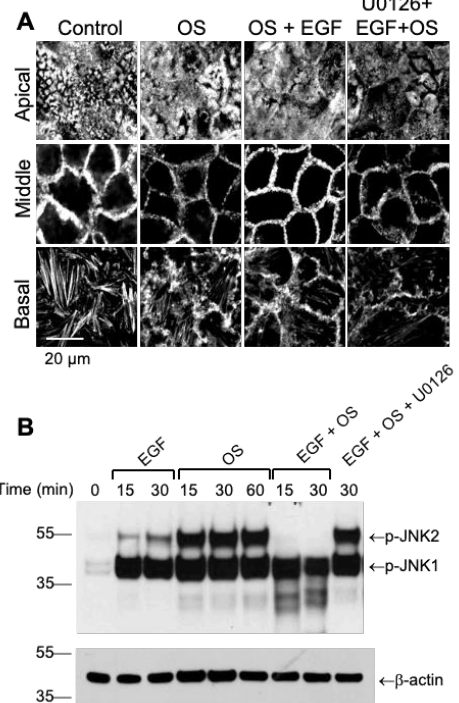
Figure 5. EGF prevents osmotic stress-induced actin cytoskeleton remodeling by a MAP kinase- dependent mechanism. Caco-2 cell monolayers (13 days post-seeding) were pretreated with or without U0126 (10 µ M) for 30 min before incubation with EGF (30 nM). After 30 min EGF treatment, cell monolayers were exposed to osmotic stress (OS) by incubation in the hyperosmotic medium; the control group received similar treatment without EGF, U0126, or OS. ( A ) After one hour of OS treatment, cell monolayers were fixed and stained for F-actin using AlexaFluor-488-labeled phalloidin. Confocal fluorescence images from 2 µ m optical sections at the apical, middle, and basal regions of the cells are presented. ( B ) Caco-2 cell monolayers (17 days post-seeding) were treated similar to panel ( A ). At varying times after OS with or without EGF and U0126, Caco-2 cell extracts were immunoblotted for JNK(pT183/pY185) and β-actin. Numbers on the left border of the images represent the molecular weight of markers.